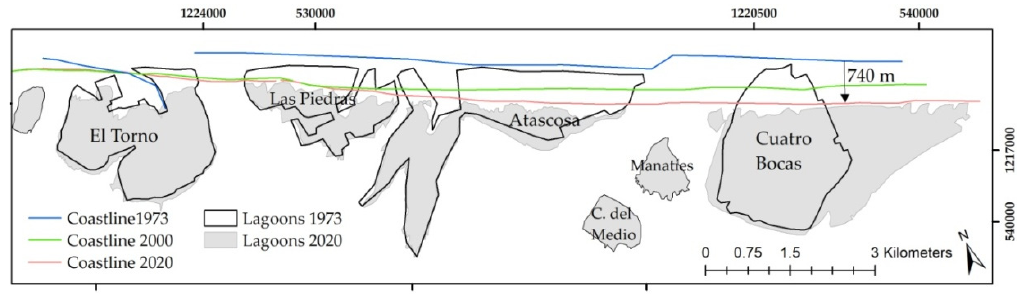
Figure 14. Landward translation of coastlines and lagoons since 1973. Table 3. Distribution of average morphometry metrics for lagoons in the Magdalena River Deltaic Barrier for 1973–2020.